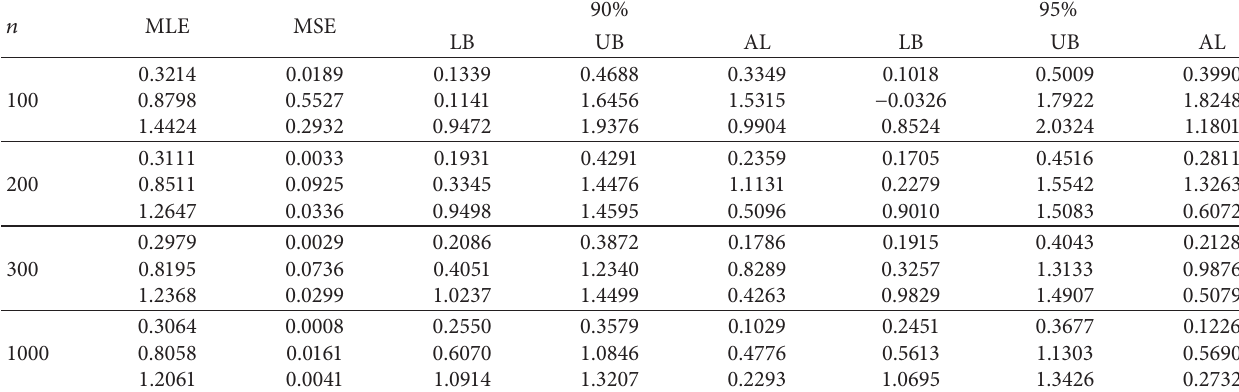
Table 8: Values of the MLEs, MSEs, and elements of CIs associated with the NTMW model parameters for Set4.